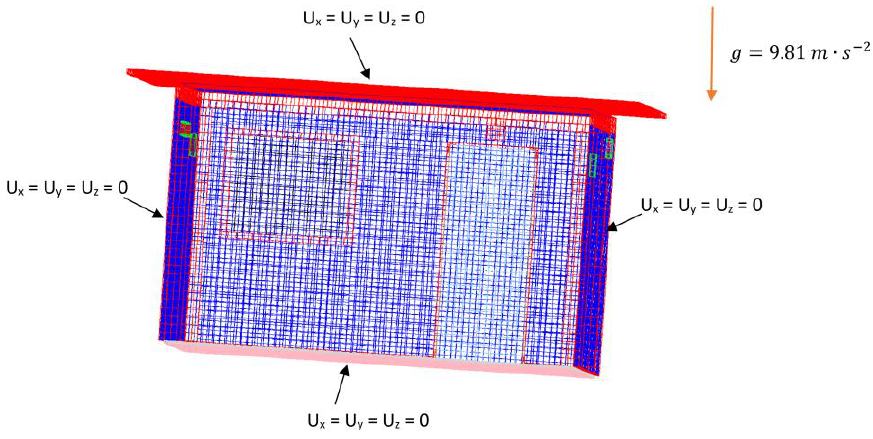
Figure 7. Mechanical boundary conditions. Table 5. Air characteristics depending on temperature.